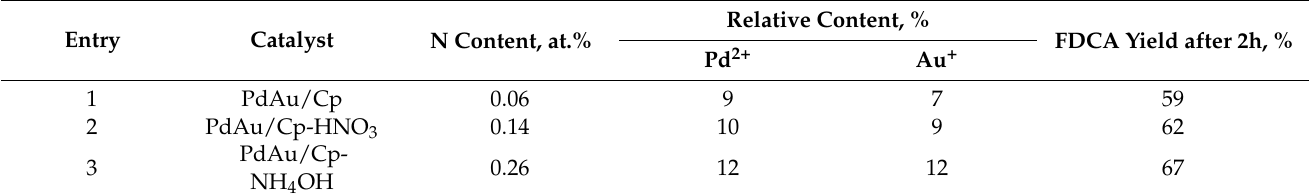
Table 11. Relation between structural and electronic properties of catalysts and their catalytic results. Entry